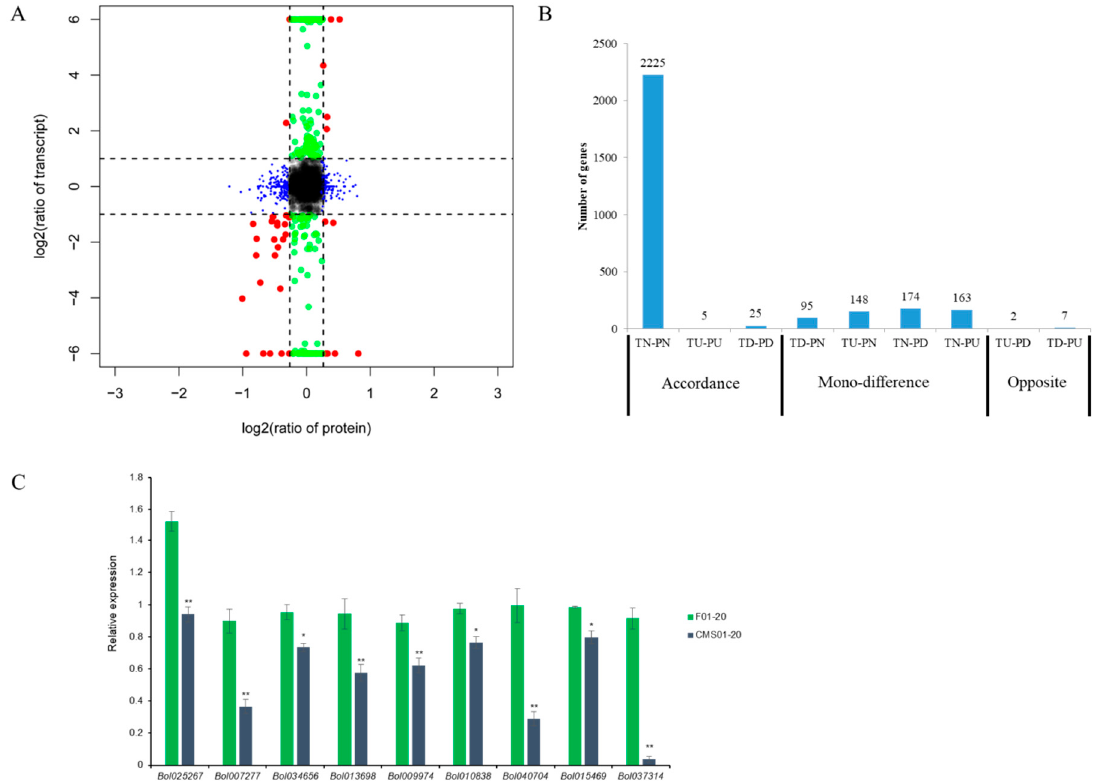
Figure 6. Integrative analyses comparing proteome and transcriptome data. ( A ) Genes were divided into nine groups according to log 2 ratios of the protein species ( y -axis) and transcripts ( x -axis); ( B ) Number of genes among the nine groups in ( A ). T: transcript; P: protein species; N, no difference; U: up-accumulation; D, down-accumulation. ( C ) Expression validation for nine key genes by qRT-PCR. * p < 0.05, ** p < 0.01.